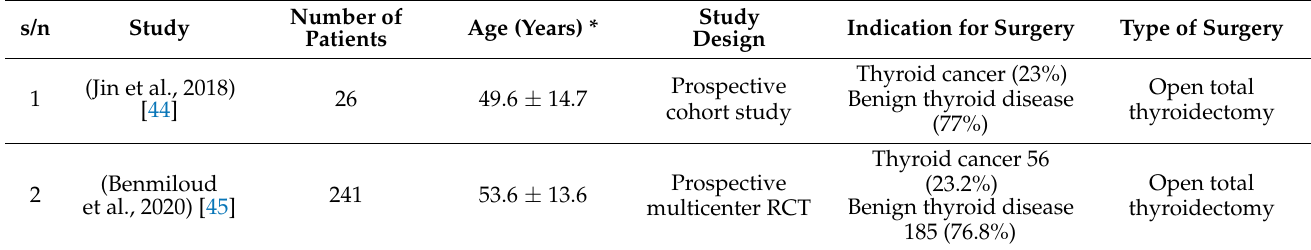
Table 1. Study characteristics of included studies. * Mean ± standard deviation unless otherwise